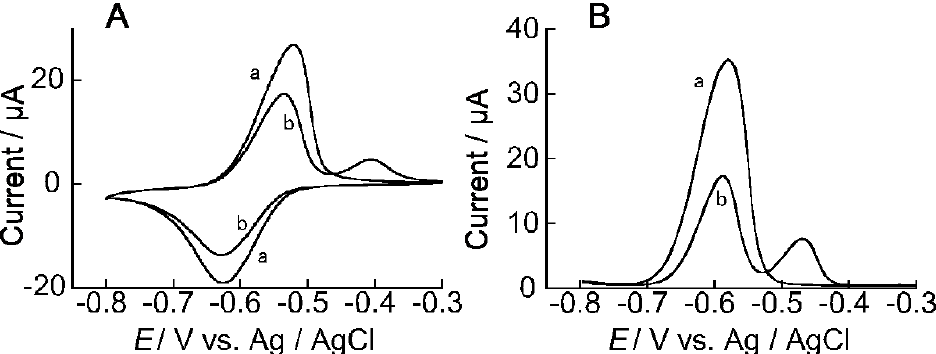
Figure 6. ( A ) CVs of the ARS-immobilized (PEI/CMC) 10 PEI film-coated Au electrode recorded in the absence (a) and presence of 1 mM PBA (b) in 10 mM HEPES buffer at pH 7.5. Scan rate, 50 mV s − 1 . ( B ) DPVs of the ARS-immobilized (PEI/CMC) 10 PEI film-coated Au electrode recorded in the absence (a) and presence of 1 mM PBA (b) in 10 mM HEPES buffer at pH 7.5.